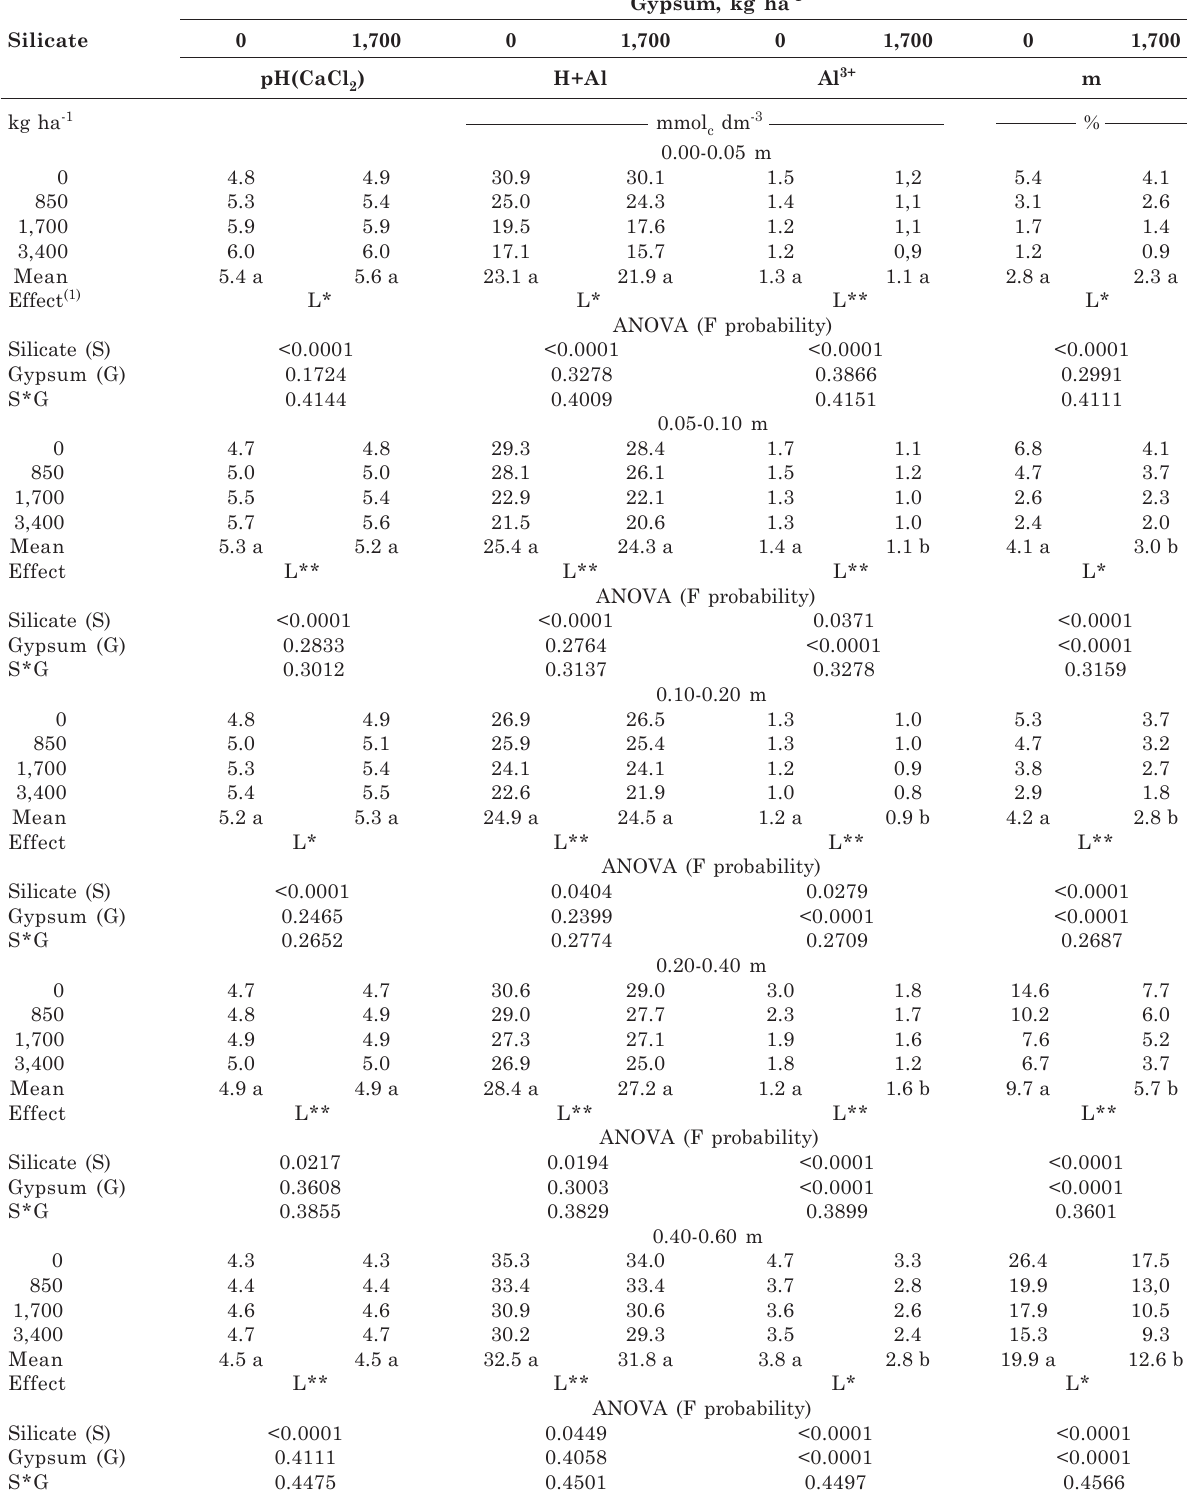
Table 1. Values of pH in CaCl 2 , total acidity at pH 7.0 (H+Al), exchangeable Al (Al 3+ ), and Al saturation (m) of soil samples taken 12 months after Ca-Mg silicate and gypsum surface application on green sugarcane, and ANOVA significance at five soil